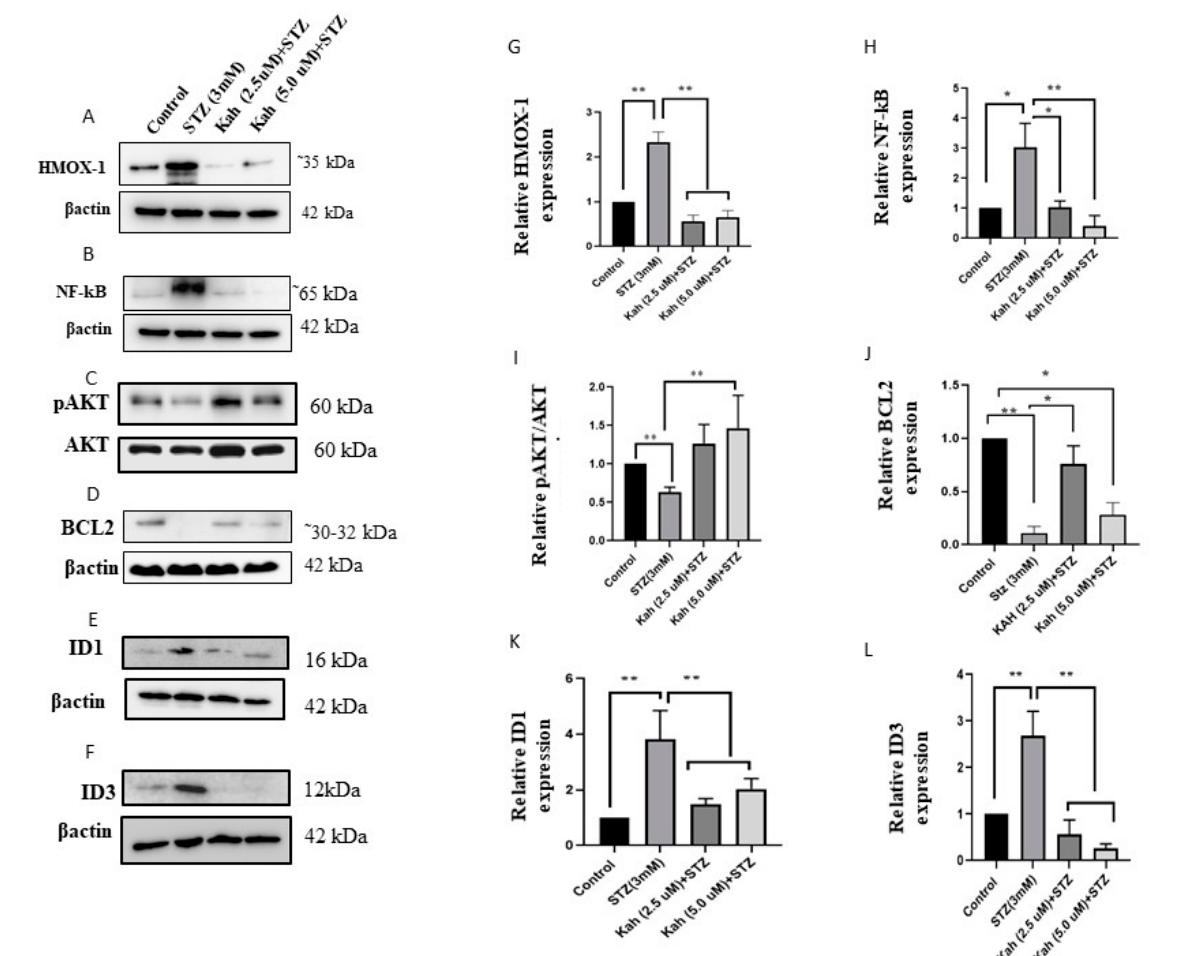
Figure 5. Effect of kahweol on the protein expression in STZ-treated cells. Western blot analysis of HMOX1 ( A , G ), NF- κ B ( B , H ), p-AKT ( C , I ), Bcl2 ( D , J ), ID1 ( E , K ), and ID3 ( F , L ) in STZ-treated cells for 3 h or cells pre-incubated with kahweol for 24 h followed by STZ-treatment compared to control cells. β -actin was used as endogenous control. * p < 0.05 and ** p < 0.01. Bars represent mean ± SD.